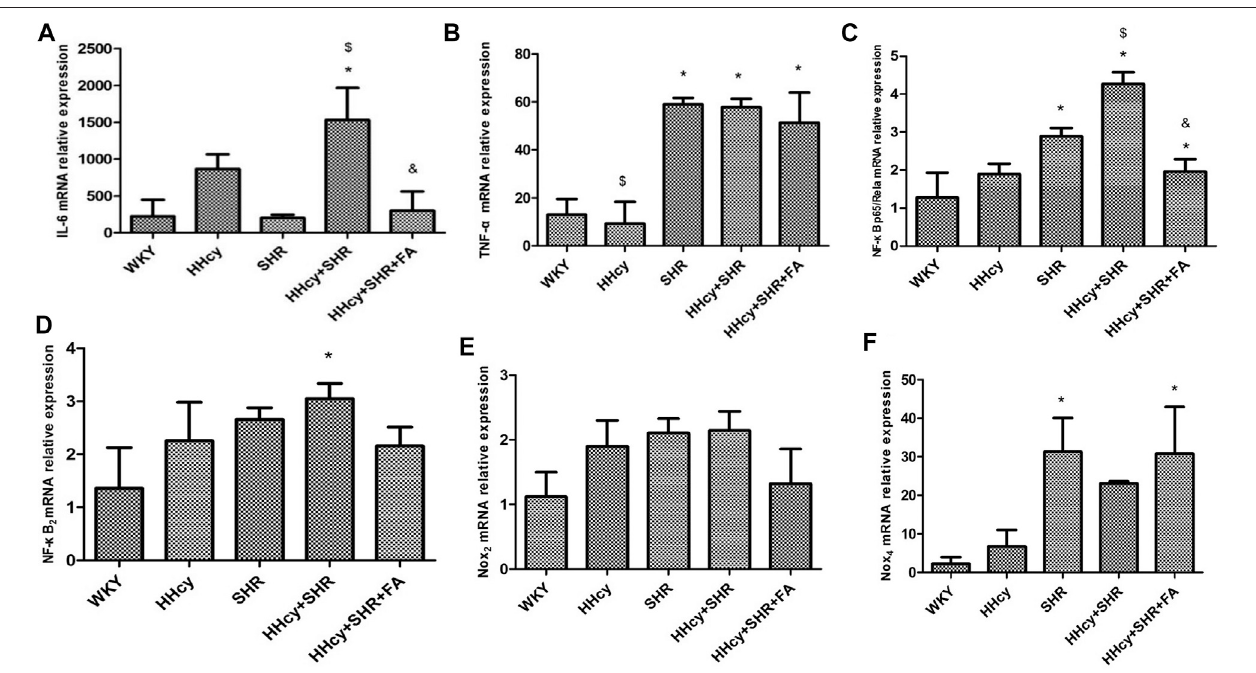
FIGURE 4 | The mRNA relative expression levels by quantitative real-time polymerase chain reaction (qRT-PCR) analysis in Wistar-Kyoto (WKY) group, hyperhomocysteinemia (HHcy) group, spontaneously hypertensive rat (SHR) group, HHcy + SHR group, and HHcy + SHR + folate (FA) group. (A) The mRNA relative levelofinterleukin-6(IL-6). (B) ThemRNArelativeleveloftumournecrosisfactor-alpha(TNF- α ). (C) ThemRNArelativelevelofnuclearfactor- κ -genebinding(NF- κ B)p65/ Rela. (D) The mRNA relative level of NF- κ B2. (E) The mRNA relative level of nicotinamide adenine dinucleotide phosphate (NADPH) oxidase (Nox) 2 . (F) The mRNA relative level of Nox 4 . Values represent means ± SD (* p < 0.05 vs. the WKY group, $ p < 0.05 vs. the SHR group, & p < 0.05 vs. the HHcy + SHR group, n (cid:1)